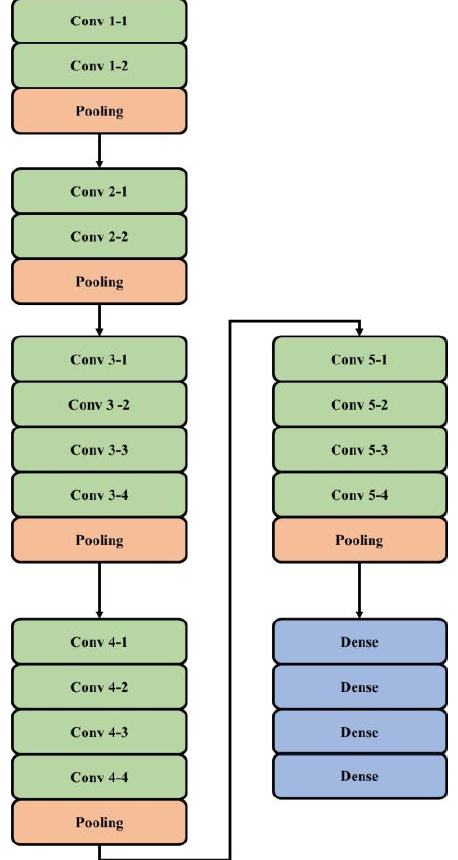
Figure 8. VGG19 architecture for feature extraction on scene classification.